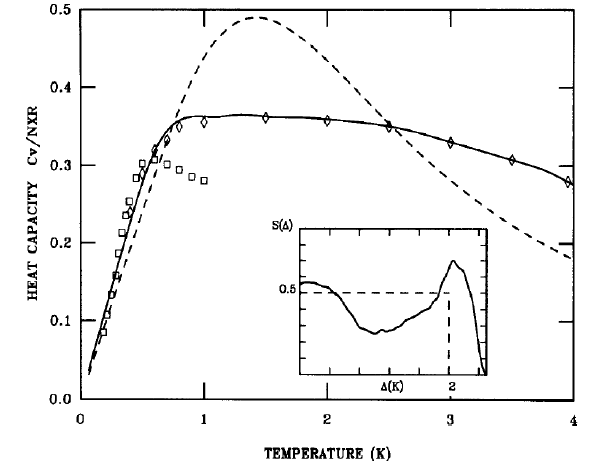
Figure 19. Heat capacity of the glass state of solid ortho-para hydrogen mixtures calculated from density of energy levels S ( ∆ ) . The diamonds represent the data of Ricketson [51] and the squares that of Haase et al.[54]. Reproduced with permission from [39]. Copyright Elsevier,